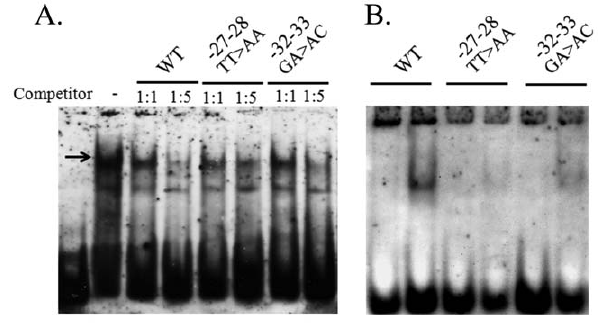
Figure 4. Mutations at the E2F/NF-e/c-Myb binding site affect binding of protein complexes to the vav1 promoter invitro . (A) Electrophoretic mobility shift assay (EMSA) with Jurkat nuclear extracts was performed in the presence of digoxigenin-labeled probe spanning nucleotides 2 45 to 0 of vav1 promoter and containing E2F/NF-e/c-Myb and TCF a /PU.1/ELF1 binding sites (lil157-158; Table 3). The competition assay was performed with the labeled oligonucleotide and unlabeled competitor oligonucleotides with point mutations as indicated in Table 3 in molar ratio of 1:1 and 1:5. The arrow shows the position of the complex that demonstrates sensitivity to the introduced mutations. (B) EMSA performed with labeled oligonucleotide containing only E2F/ NF-e/c-Myb binding site (lil 87-88; Table